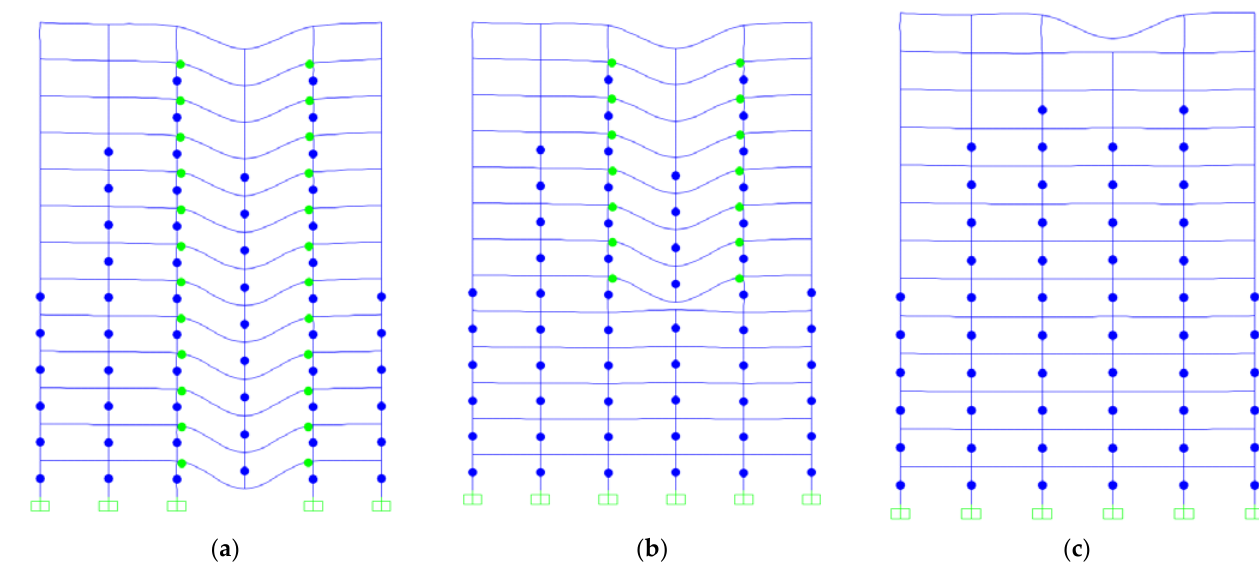
Figure 14. Hinge formation in the frame with CFRP exposed to column removal in ( a ) story one, ( b ) story six, and ( c ) story thirteen.